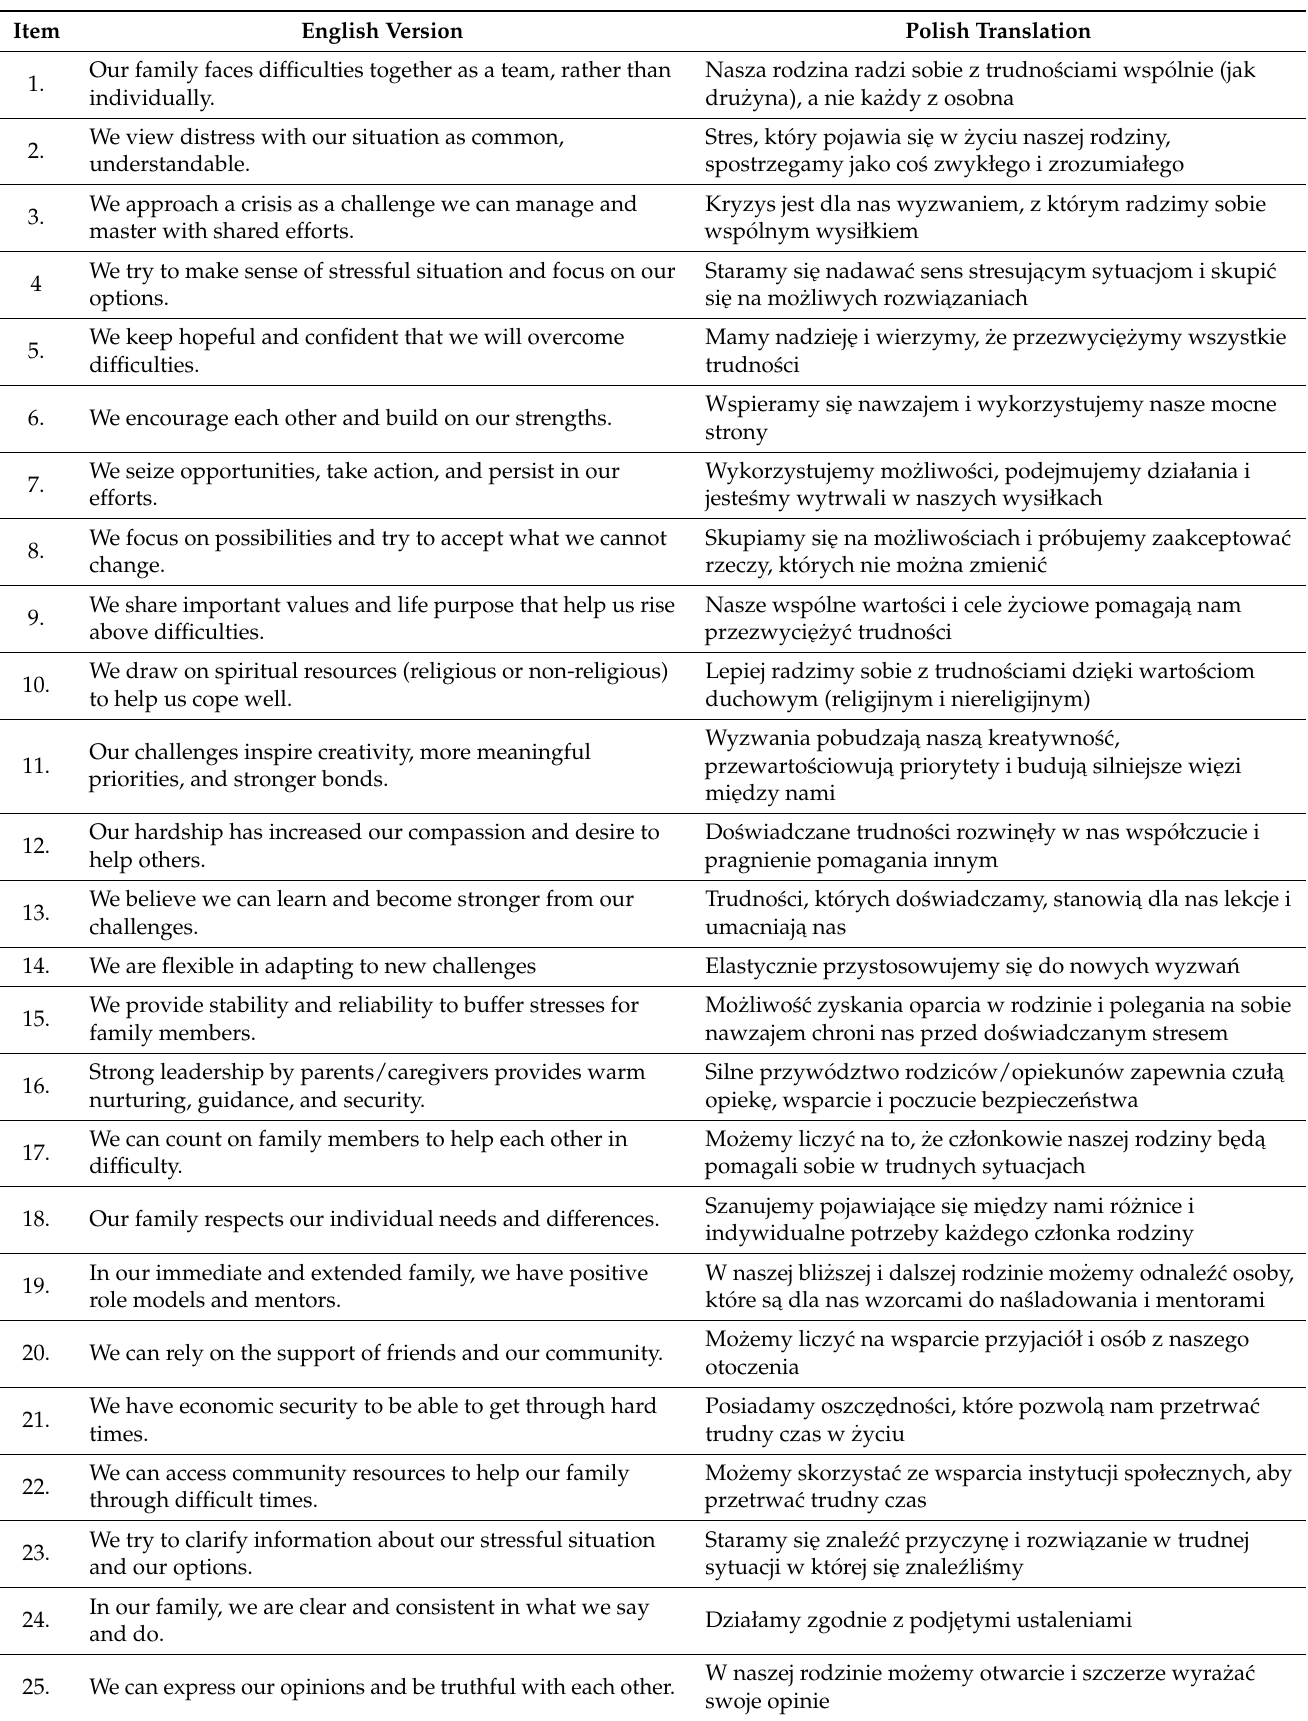
Table 1. Polish translation of Walsh Family Resilience Questionnaire